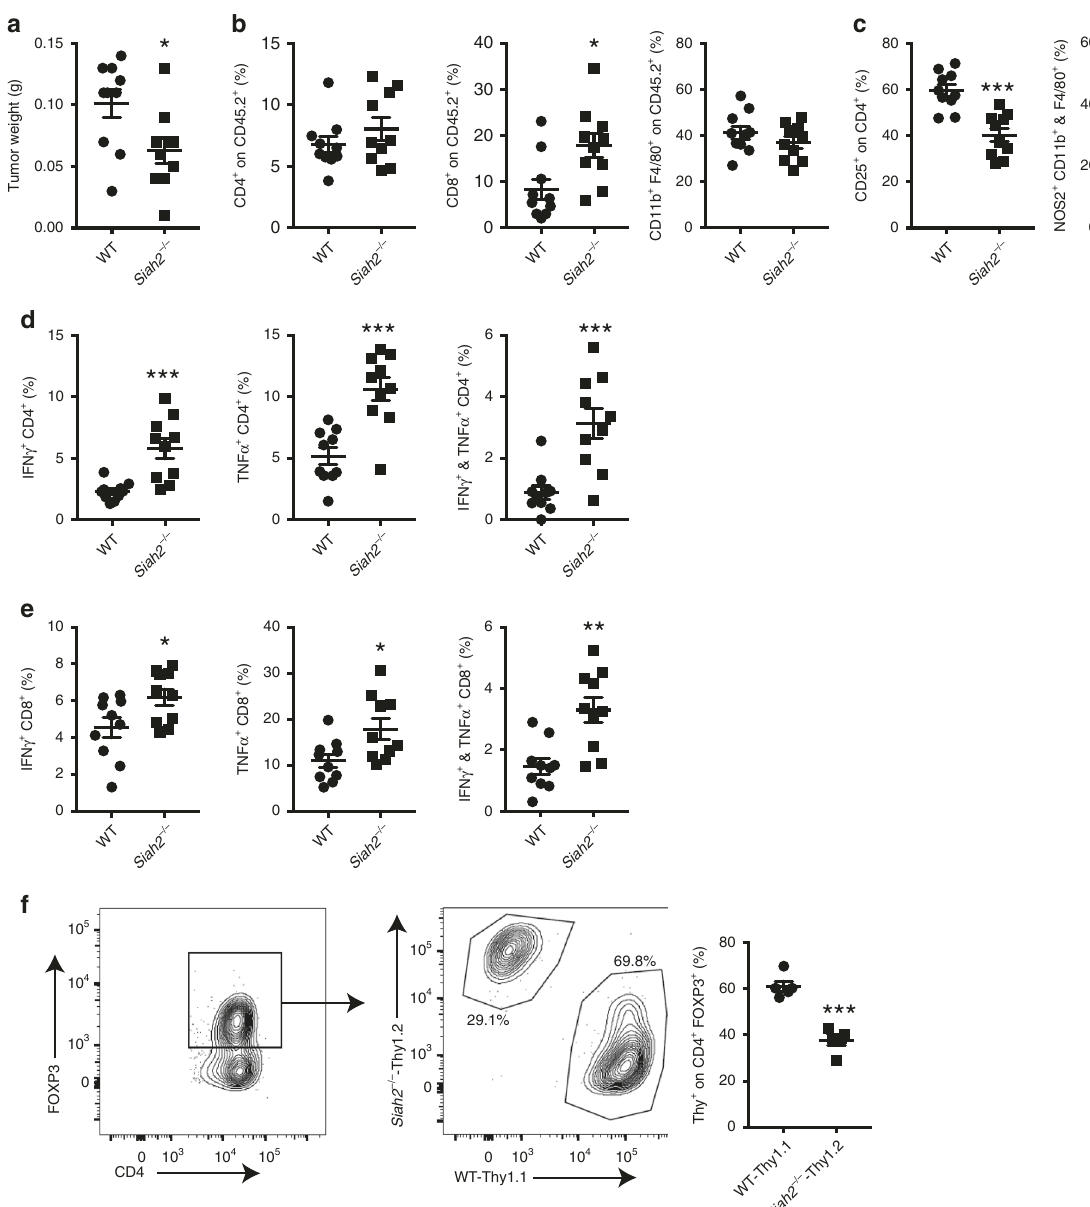
Fig. 3 Decreased tumor growth in Siah2 − / − BM-transplanted mice. a Weight of tumors collected 14 days after YUMMER1.7 cell inoculation into lethally irradiated mice transplanted with bone marrow (BM) from WT or Siah2 − / − mice ( n = 10). b Frequencies of tumor-in fi ltrating CD4 + , CD8 + T cells, and CD11b + /F4/80 + cells among CD45 + cells on day 14 after tumor cell injection ( n = 10). c Frequencies of CD25 + cells among CD4 + cells and NOS2- producing CD11b/F4/80-positive cells ( n = 10). d , e Frequencies of tumor-in fi ltrating TNF- α - and IFN- γ -producing CD4 + d and CD8 + e T cells on day 14 after tumor inoculation and following overnight stimulation in vitro with melanoma peptides ( n = 10). f A 1:1 mixture of BM from Thy1.1 + CD45.2 + WT and Thy1.2 + CD45.2 + Siah2 − / − mice was injected into lethally irradiated CD45.1 + mice. YUMMER1.7 cells were injected 8 weeks after reconstitution and tumors collected 14 days later. CD4 + Foxp3 + cells were gated and percentages of WT Thy1.1-positive and Siah2 − / − Thy1.2 + cells were determined ( n = 5); mean ± s.e.m. Data were analyzed by unpaired t -test. *** P < 0.0005, ** P < 0.005, and * P < 0.05 compared with